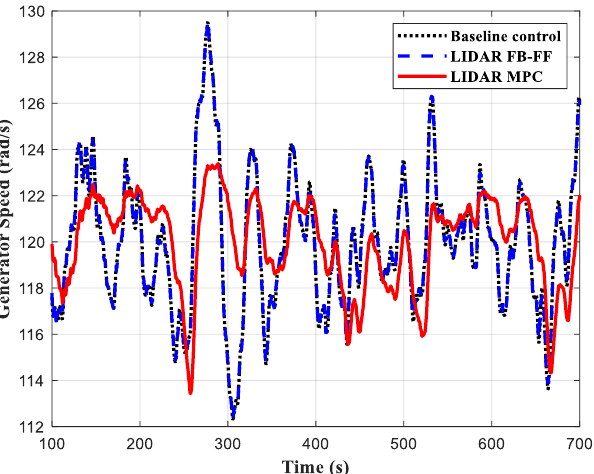
Figure 13. Tower fore-aft acceleration: ( a ) time profiles; ( b ) cumulative PSD (for wind speed with 15% turbulence intensity).